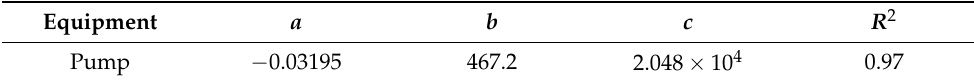
Table 4. The coefficients of Equation (4) for centrifugal